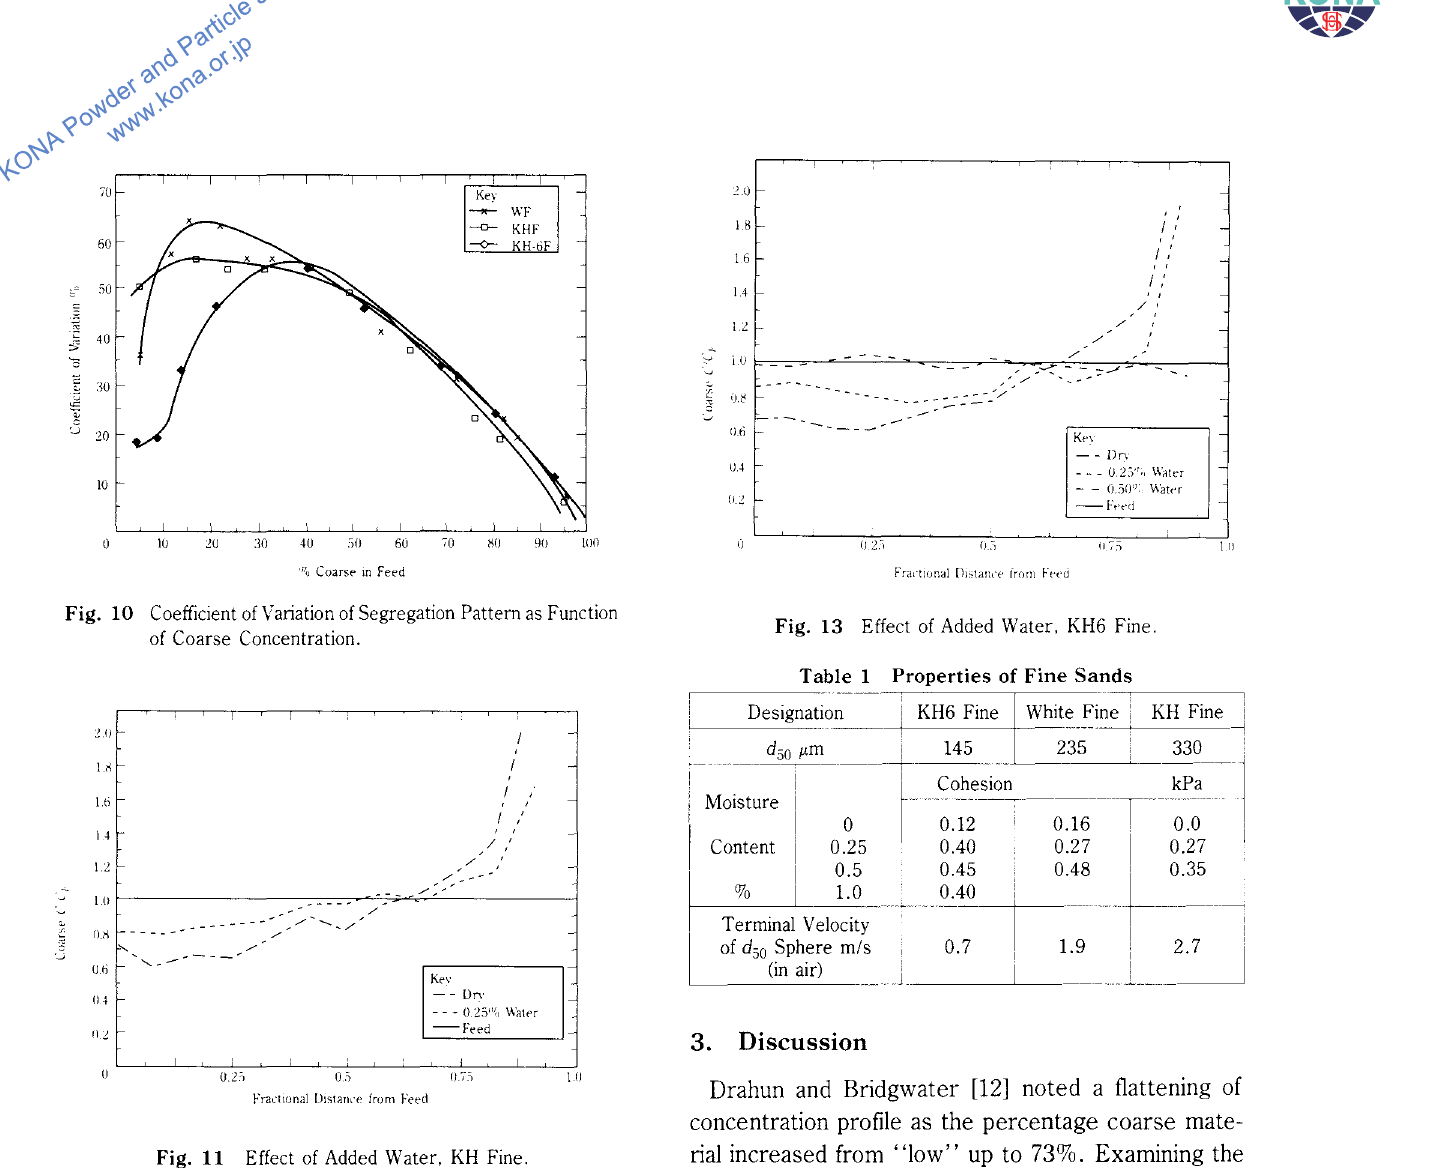
Fig. 11 Effect of Added Water, KH Fine.